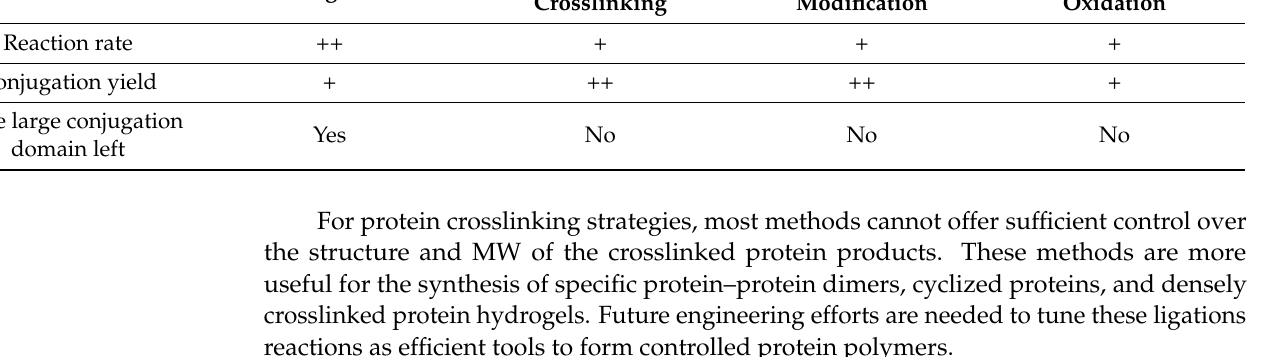
Table 3. Comparison between different methods for crosslinking of proteins using side-chain chem- istry. “ − “, “+” and “++” symbols indicate the respective levels of each criterion. Catcher/Tag